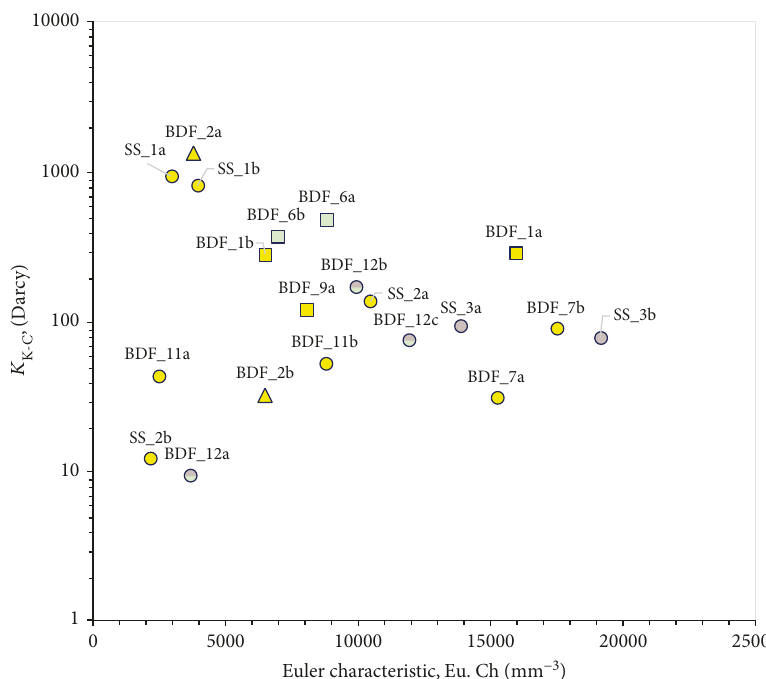
Figure 11: Scatter plot indicating the permeability estimates with the Kozeny-Carman equation (k Kozeny-Carman equation [92, 93], it was assumed that both the tortuosity (equal 1.5) and pore shape factor (equal 5) are constant. Rock samples with a higher permeability, wider pores, and better connectivity (more pervious) are localized to the upper left area. Rock samples located to the right of the graph tend to have a poorly connected pore network (more impervious). Description of the samples is located in Table 2. Detailed results in Table 4. Samples in bold can be observed in Figure